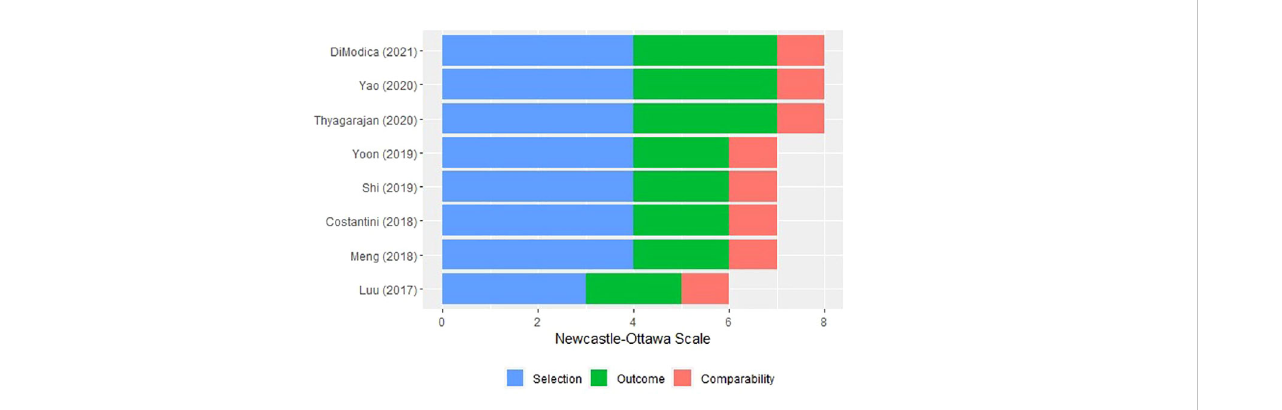
FIGURE 3 Risk of bias of the included cohort studies via Newcastle – Ottawa scale.